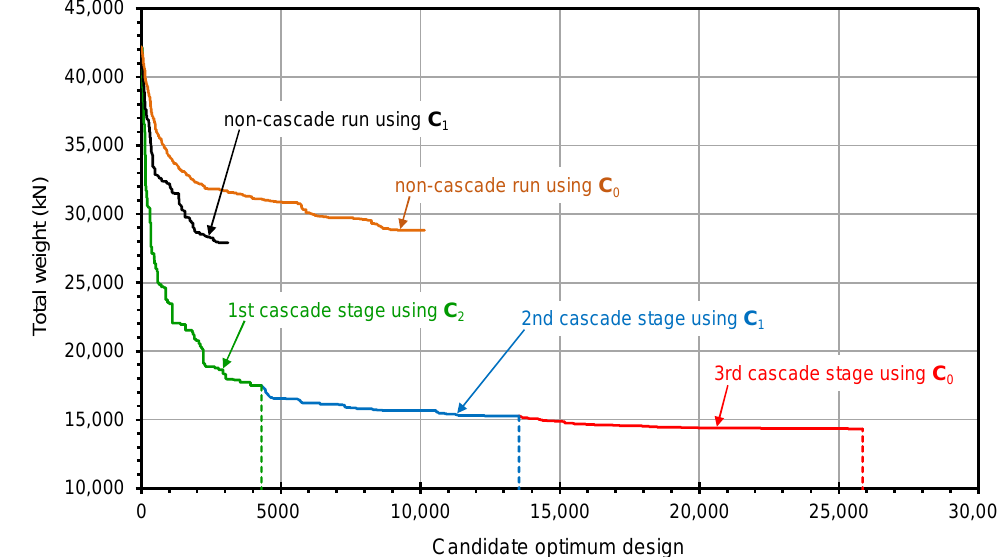
Figure 10. Test Problem 2 (36-story steel space frame): convergence histories of non-cascade and cascade optimization